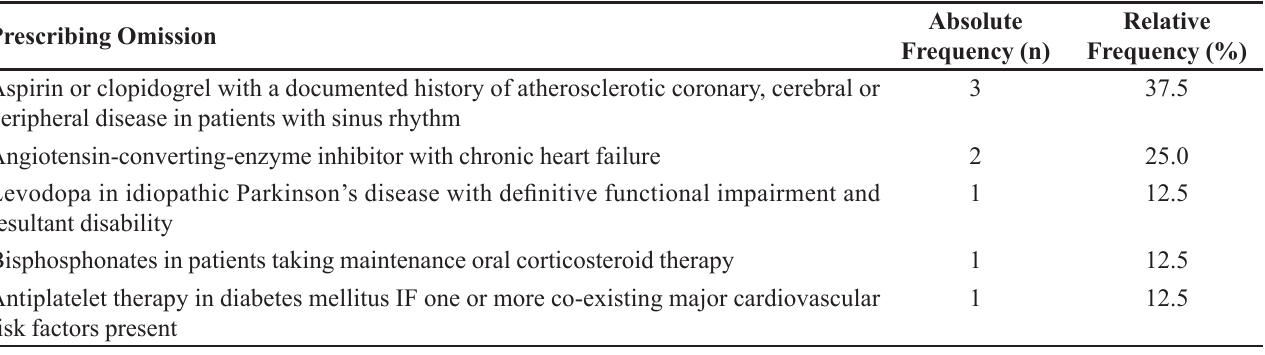
TABLE IV - Frequency of prescribing omissions Prescribing